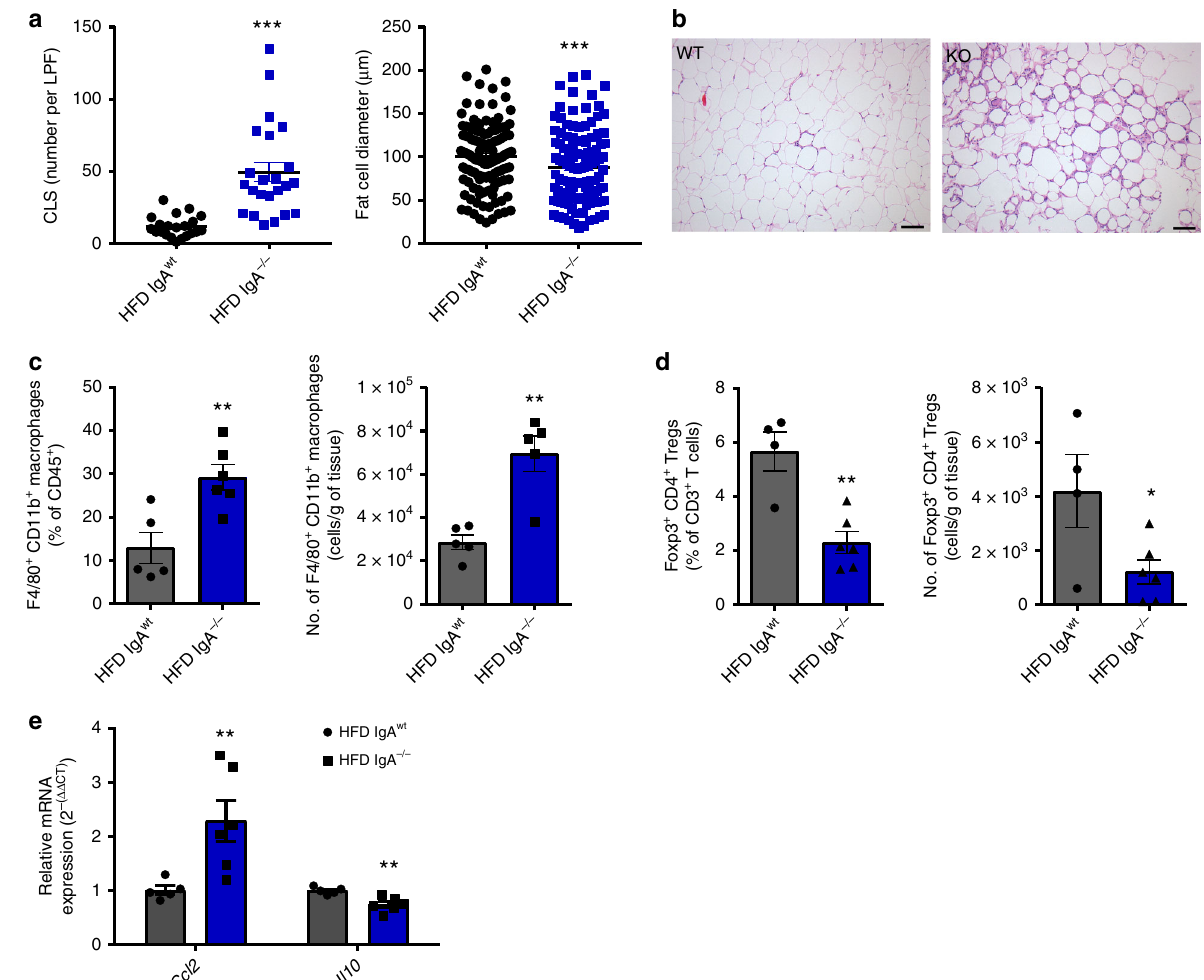
Fig. 5 Immunoglobulin A (IgA) de fi ciency exacerbates immune-cell-mediated visceral adipose tissue (VAT) in fl ammation. a Enumeration of crown-like structures (CLS) per ×100 low power fi eld (LPF) (left) and fat cell diameter (right) within the VAT of high fat diet (HFD)-fed WT and IgA − / − after 14 weeks of diet ( n = 3 mice/group, 10 – 12 LPF per mouse for CLS, 120 – 129 cells from three mice for cell diameter). b Representative histological images of VAT of HFD-fed WT (left) and IgA − / − (right) after 14 weeks of diet (scale bar = 100 µ m). c Percentage (left) and absolute number (right) of total CD11b + F4/80 + macrophages within the VAT stromal vascular fraction measured by fl ow cytometry ( n = 5 – 6 pooled mice, three experiments). d Frequency (left) and absolute number (right) of Foxp3 + CD4 + regulatory T cells (Tregs) in the stromal vascular cells of VAT in IgA − / − mice fed HFD for 14 weeks compared to WT controls ( n = 4 WT, 6 IgA − / − pooled mice; 4 experiments). e Relative mRNA expression levels of CCL2 and interleukin-10 (IL-10) within VAT of HFD fed WT and IgA − / − mice ( n = 5 WT, 6 IgA − / − , 2 experiments). Data are means ± SEM. * denotes p < 0.05, ** denotes p < 0.01, and *** denotes p <